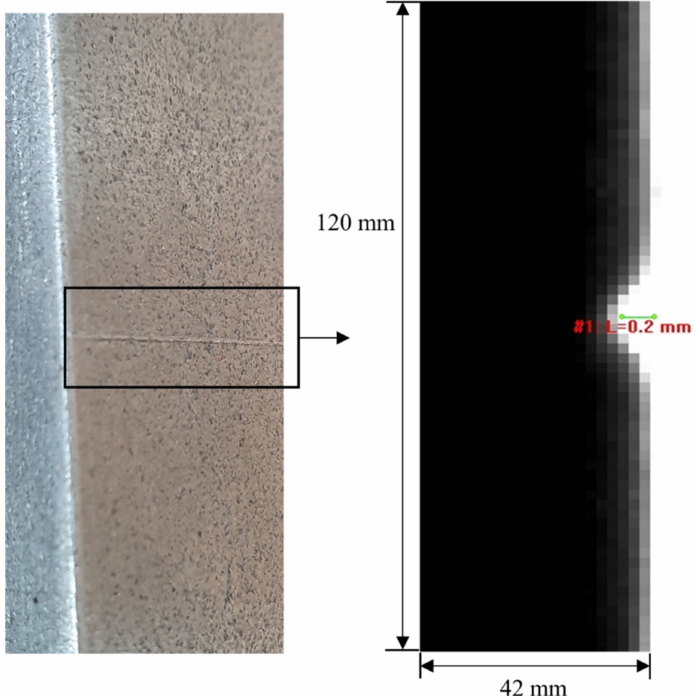
Figure 5. Measured maximum crack depth in simple specimen.